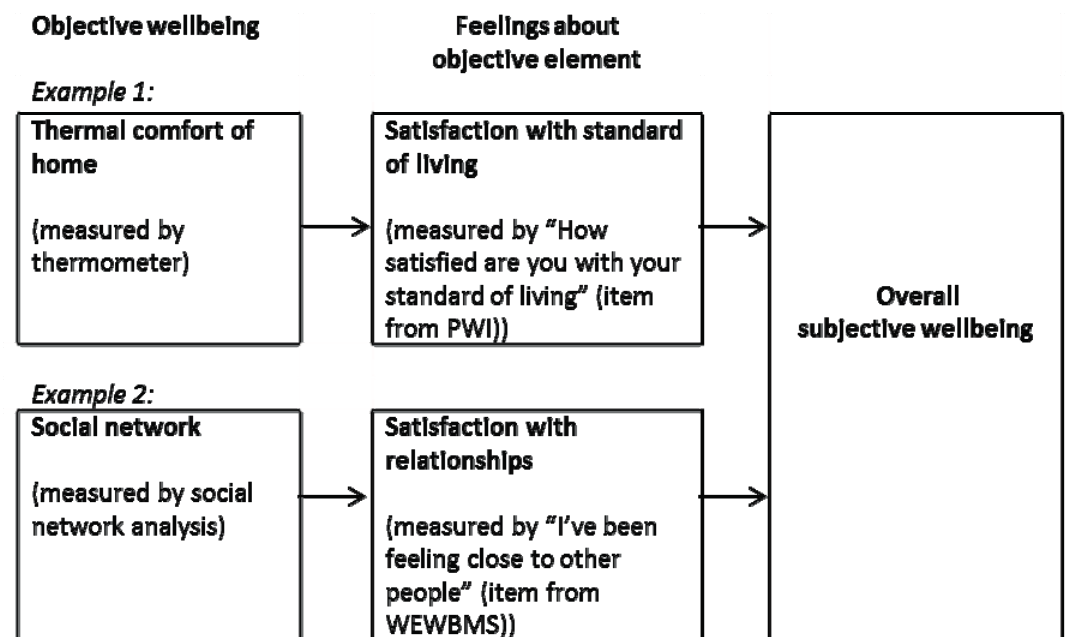
Figure 1. The continuum between objective and subjective wellbeing: an example with thermal comfort and social